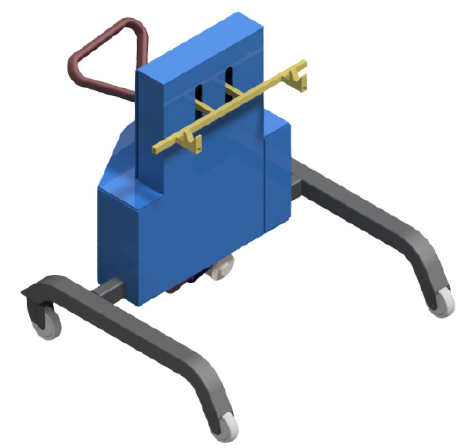
Figure 3. Isometric view of solution B.